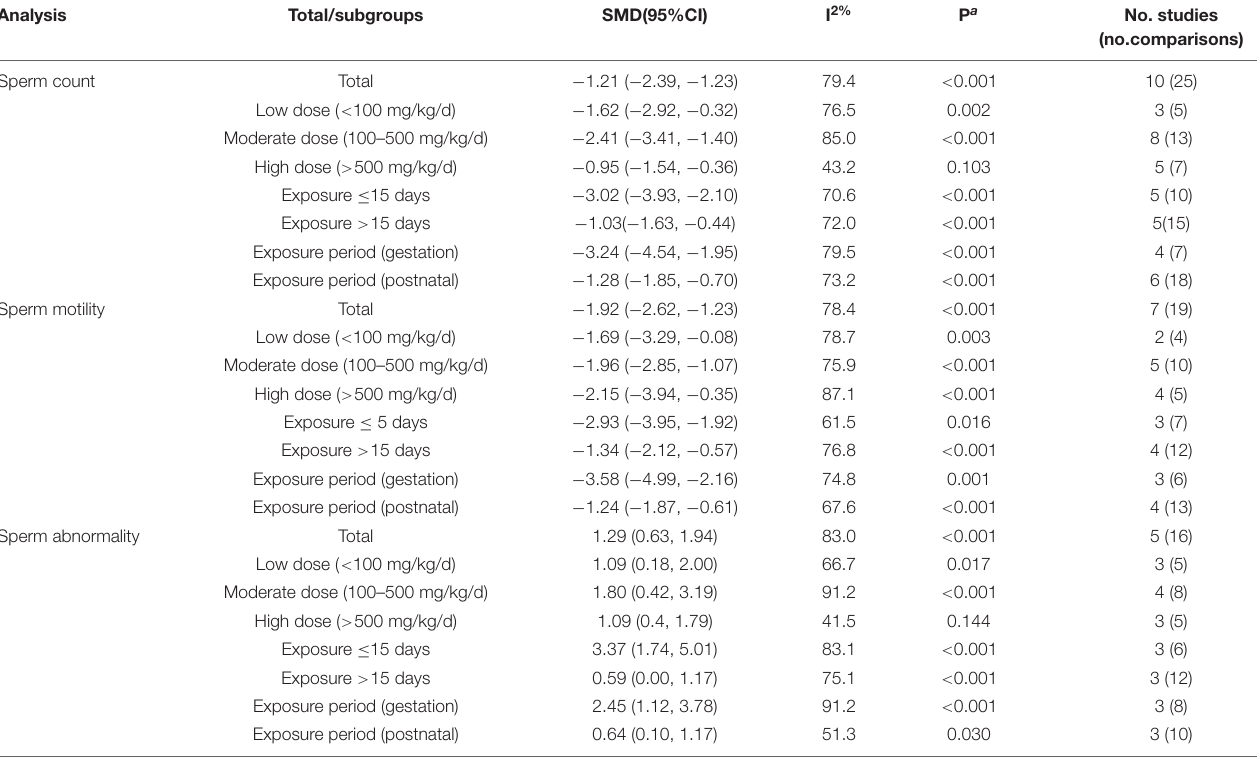
TABLE 4 | The result of meta-analysis in sperm